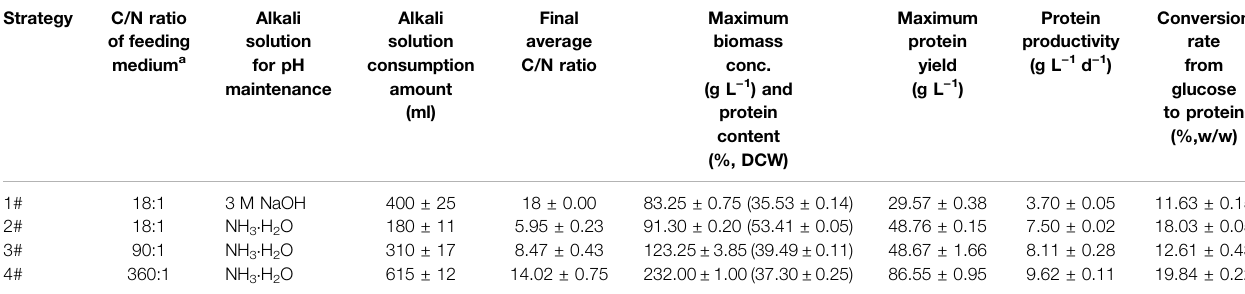
TABLE 1 | Comparison of major production performance indices of C. sorokiniana CMBB276 in 7.5 L fermenters under different culture strategies. Strategy C/N ratio of feeding